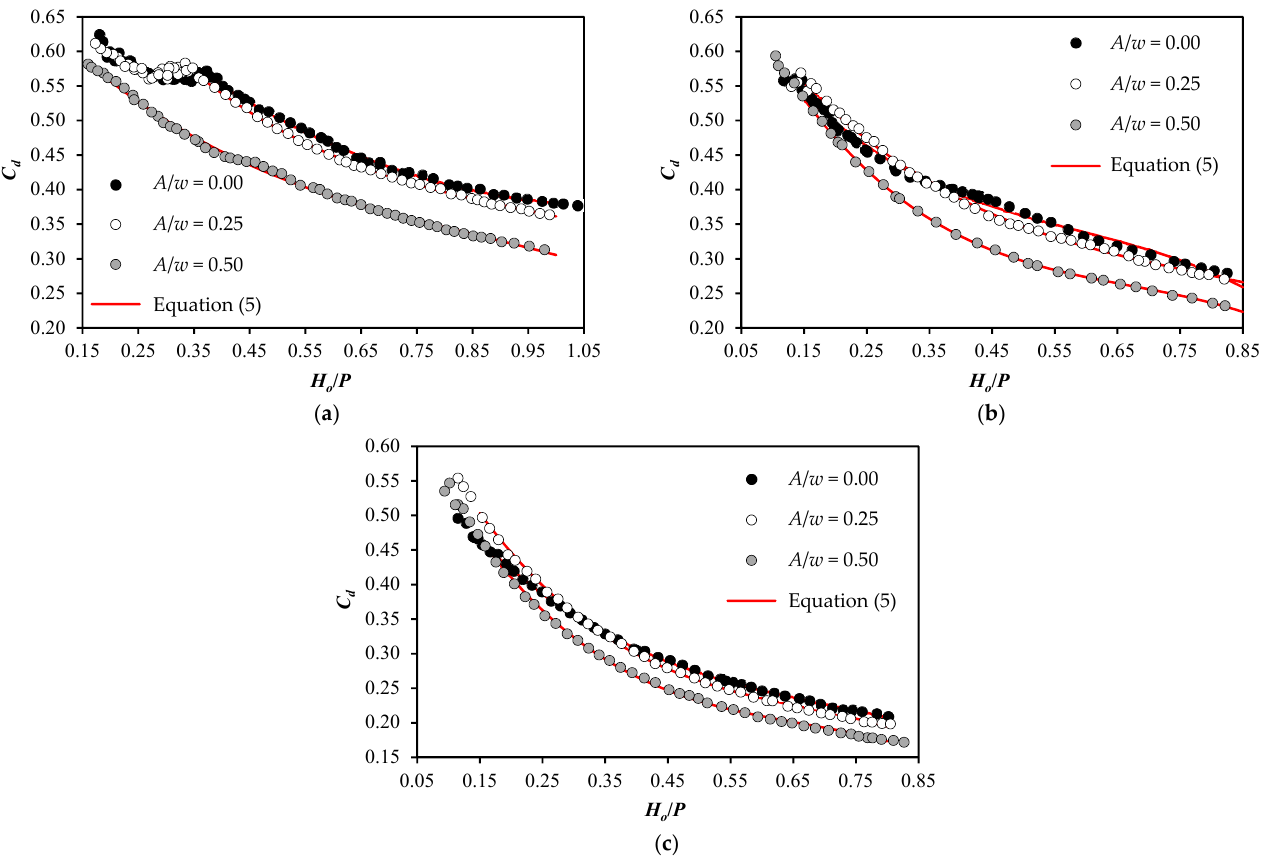
Figure 19. Variations of the discharge coefficient ( C d ): ( a ) B / w = 1; ( b ) B / w = 2; ( c ) B / w = 3. Table 3. Empirical constants of the discharge coefficient equation.